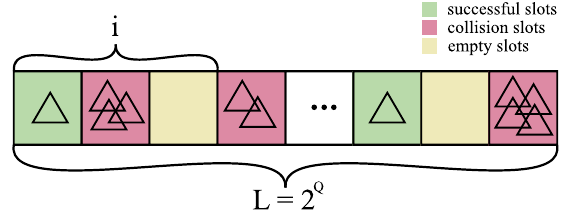
Figure 1. An example of an interrogating frame of frame size L = 2 Q . i represents the size of a particular part of the